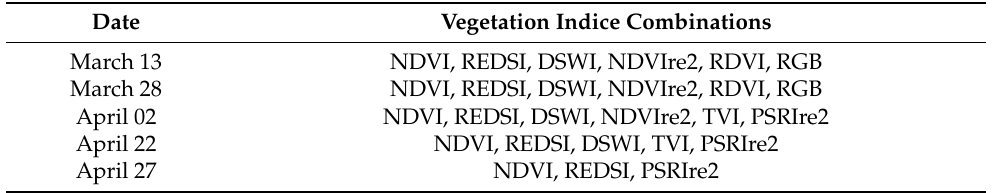
Table 5. The optimal vegetation indice combinations at five dates. Each row represents the optimal vegetation indice combinations on the corresponding date.